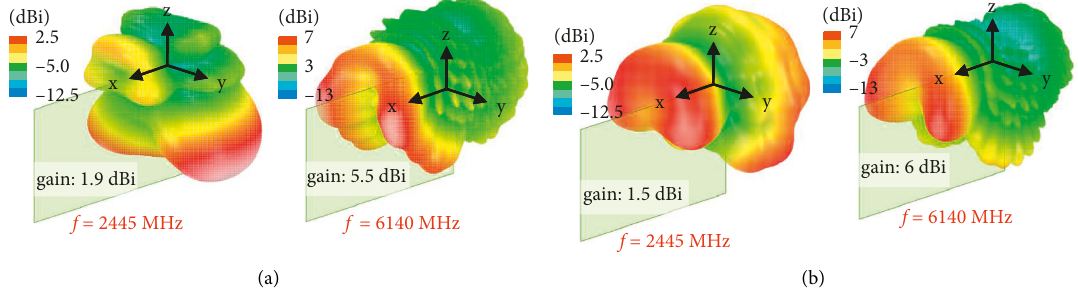
Figure 5: Simulated 3-D radiation patterns for the proposed design. (a) Ant1. (b) Ant2.